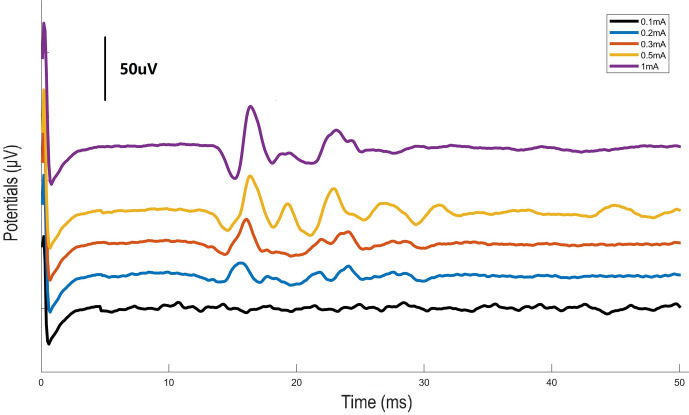
Graph illustrating the action potentials from the subdiaphragmatic vagus nerve. Electrical stimulation of the left carotid sheath with different intensities was performed and evoked potentials were measured at the subdiaphagmatic vagus nerve in mice.